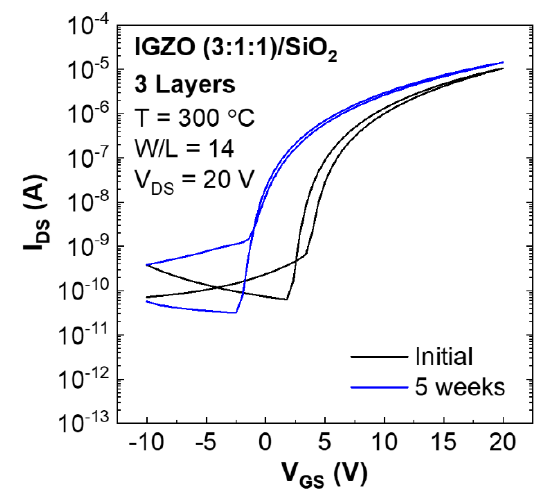
Figure 4. Transfer characteristics of a 3-layer IGZO 3:1:1 TFT as deposited and after 5 weeks. Fully solution based TFTs were produced by combining optimized 3-layer IGZO 3:1:1 with high- к solution process dielectric AlO x to enable low voltage operation. Capacitance variation with frequency of Si / AlO x / Al MIS devices is depicted in Figure S6, where C i = 306 ± 2 nF was determined for AlO x at 100 Hz. IGZO / AlO x TFTs were patterned (W / L = 160 / 20) and passivated with chemical vapor deposited parylene.